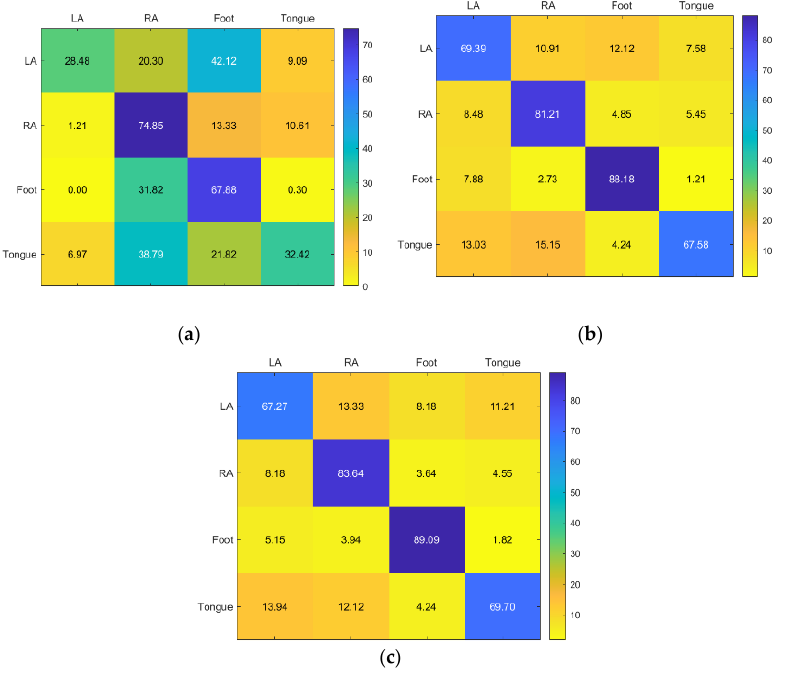
Figure 9. Confusion matrices for the ( a ) KNN, ( b ) SVM, and ( c ) RF classifiers to demonstrate the MI-BCI performance from the second subject’s four classes (left hand, right hand, feet, and tongue).